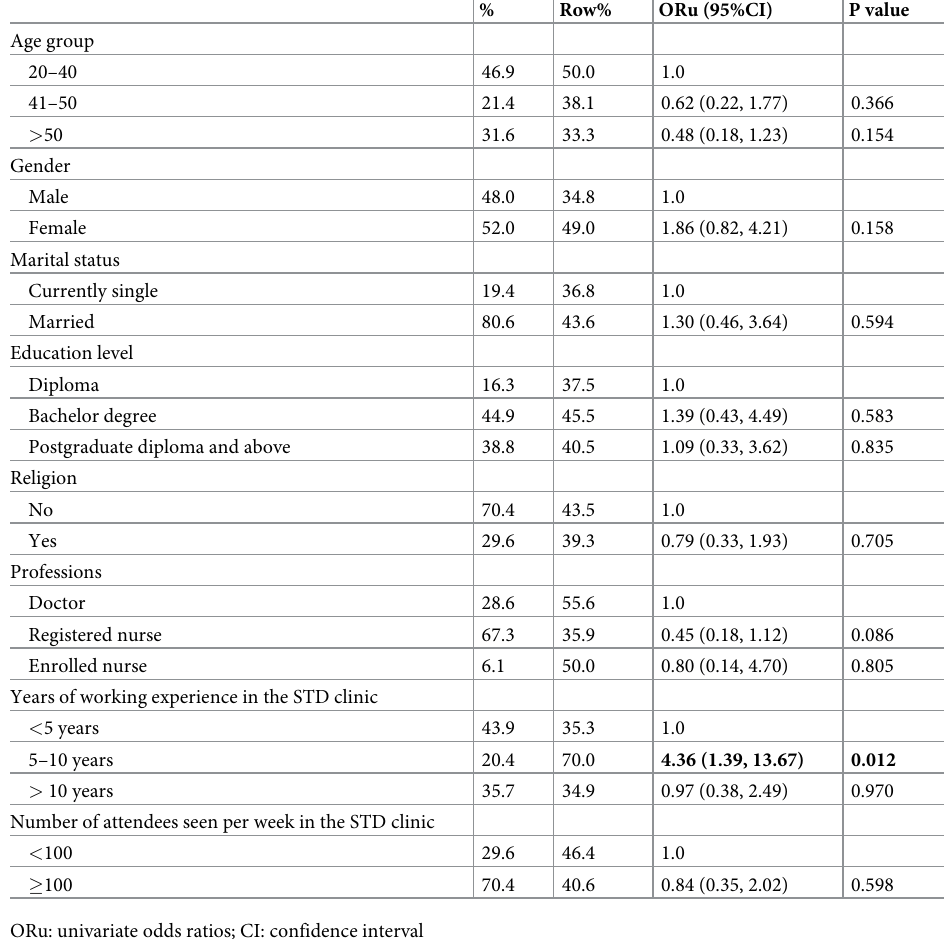
Table 3. Associations between background variables and recommendation of HPV vaccination to any STD clinic attendees (either male or female) in the last 12 months (n =